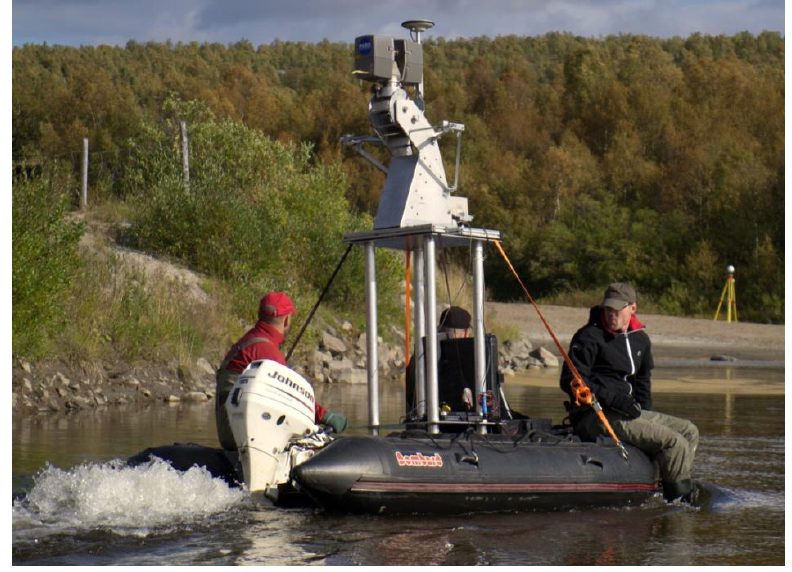
Figure 1. The boat-based mobile laser scanner used in the study.